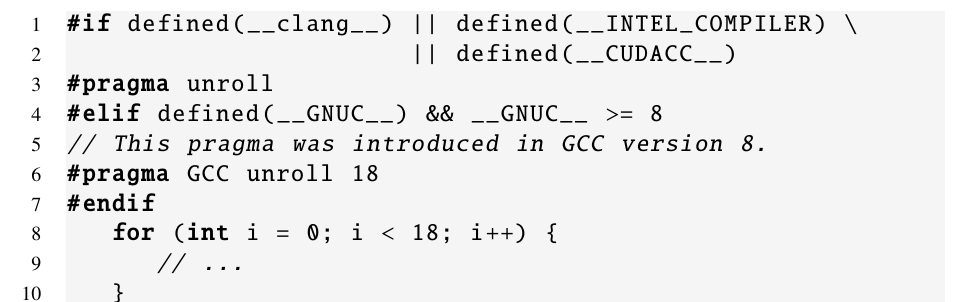
Figure 1. Performance results after each of the presented optimizations with di ff erent